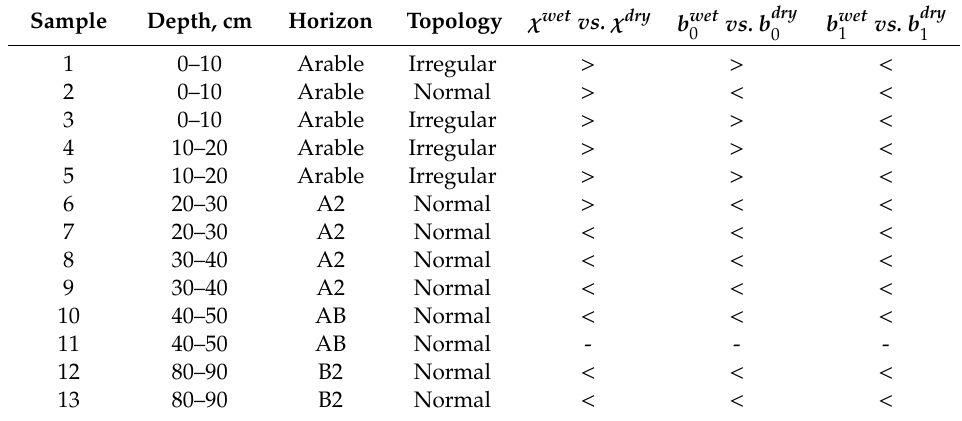
Table 1. Soil samples used in this study, indicating the occurrence depths and horizons. The three columns on the right represent the relationship between the Euler-Poincare characteristic and Betti numbers of the pore space under dry and wet conditions. Sample Depth, cm Horizon Topology χ wet vs. χ